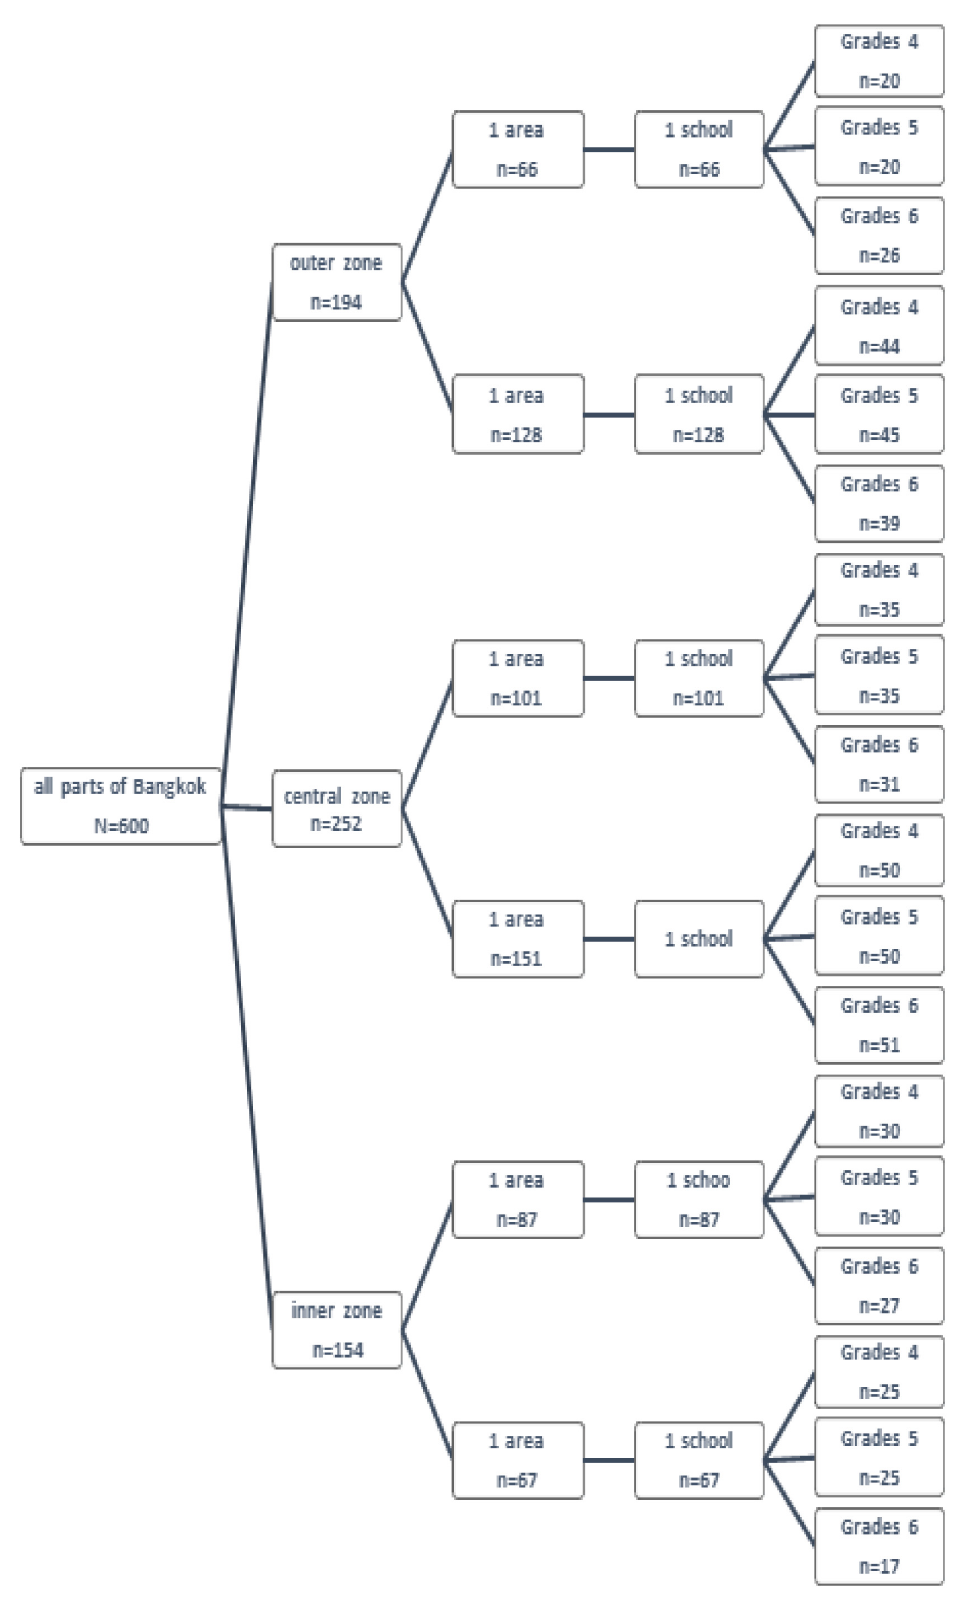
Figure 1. Chart for